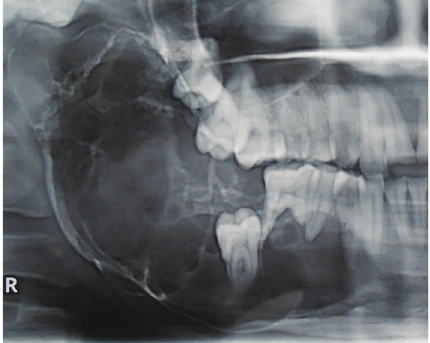
Figure 3: OPG of the female patient showing multilocular radiolu- cent lesion & root resorption of